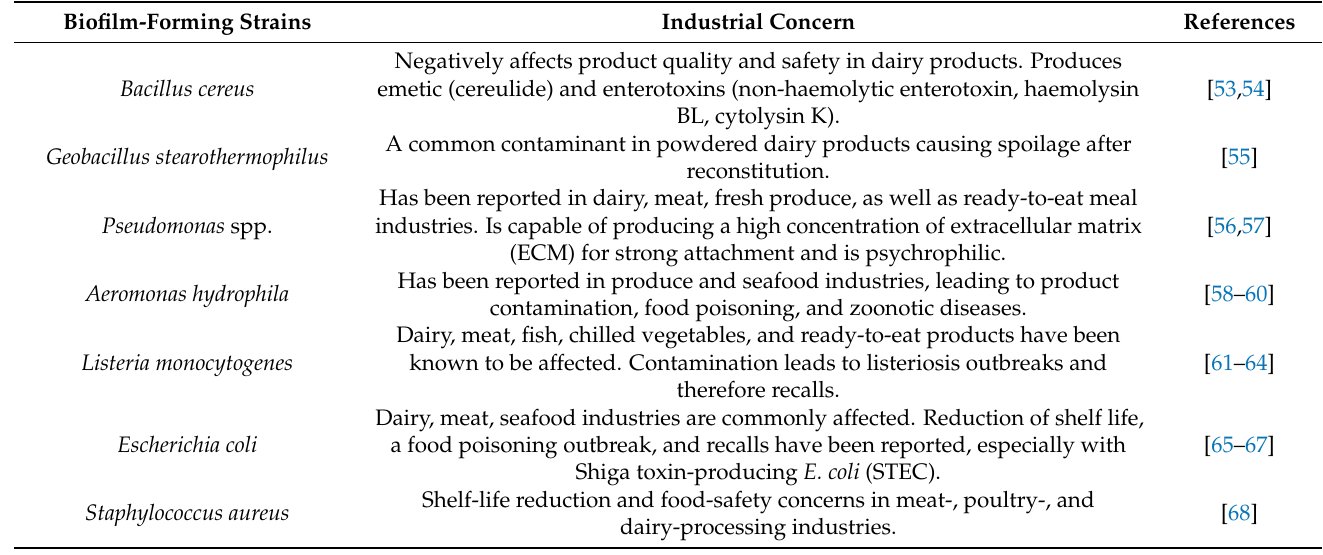
Table 3. Biofilms in food industries—microbial strains of